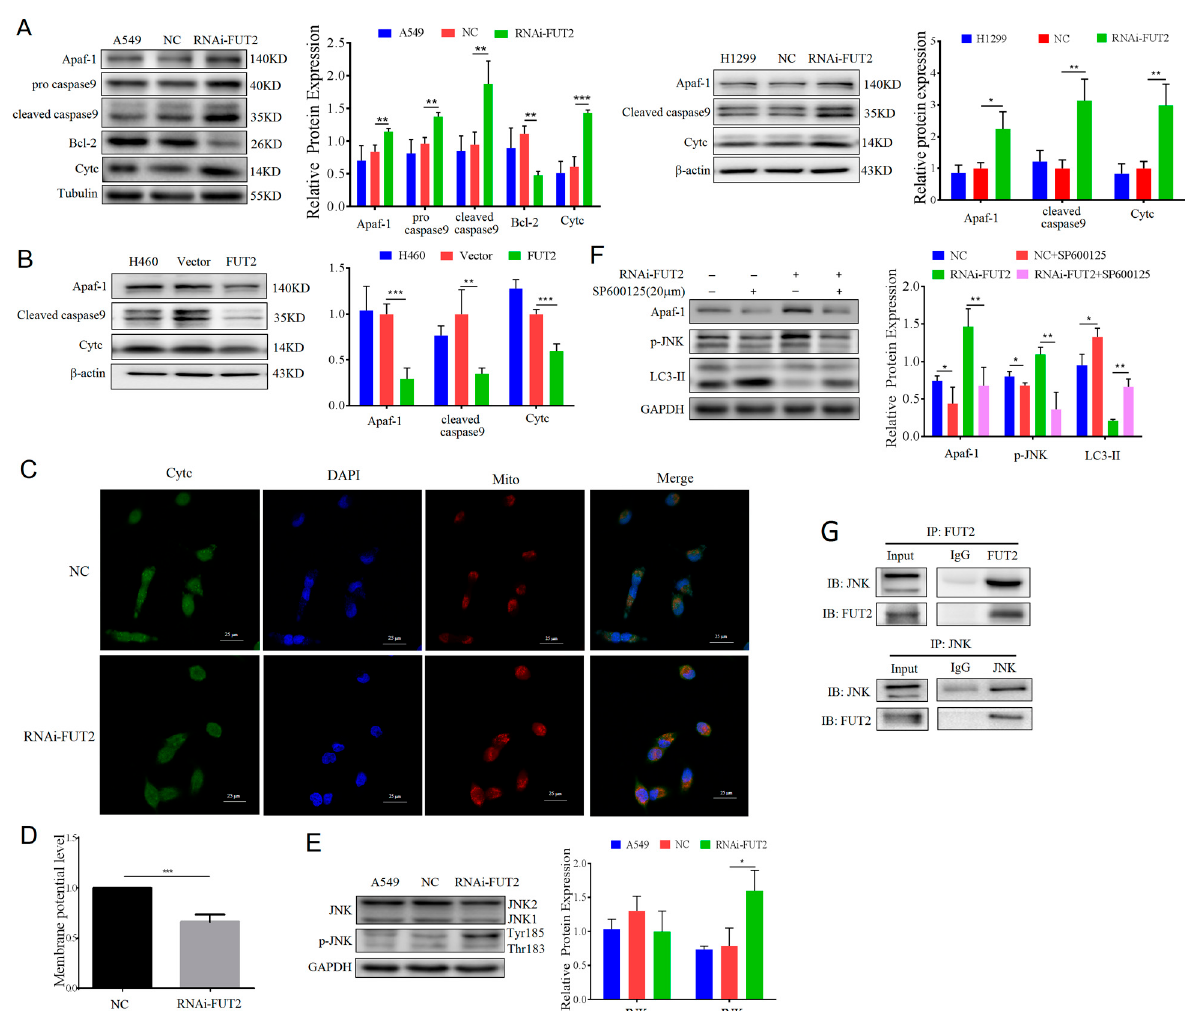
Figure 6. FUT2 depresses mitochondrial-mediated apoptosis in the JNK pathway in LUAD cells. ( A ) Representative Western blot showing that the knockdown of FUT2 increased the expressions of Apaf-1, pro caspase 9, cleaved caspase 9, Bcl-2, and Cytc in A549 and H1299 cells. ( B ) Representative Western blot showing that the upregulation of FUT2 expression reduced the expressions of Apaf-1, cleaved caspase 9, and Cytc in H460 cells. ( C ) Representative image of immunofluorescence staining showing the localization of Cytc in FUT2-knockdown A549 cells or control cells. ( D ) The MMP significantly decreased in RNAi-FUT2 A549 cells. ( E ) Representative Western blot showing that the knockdown of FUT2 increased the level of p-JNK. ( F ) Representative Western blot showing that the levels of Apaf-1, p-JNK, and LC3-II in FUT2-knockdown A549 cells or control cells in the presence and absence of SP600125. ( G ) Co-immunoprecipitation (Co-IP) assay showed an interaction between FUT2 and JNK in A549 cells. (* p < 0.05, ** p < 0.01, and *** p <